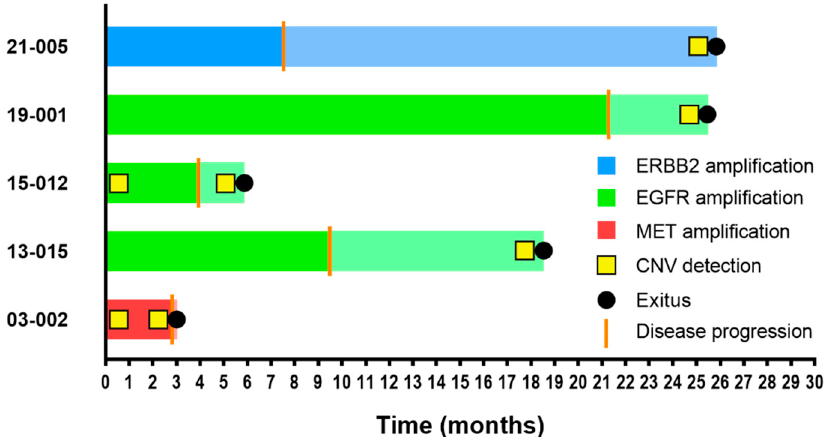
Figure 2. Swimmer plot of PFS and OS in CNV-positive patients. The PFS bar plot appears in dark color, whereas OS is represented continuing the same bar but in attenuated color. Disease progression and exitus events are shown on bar plots as a vertical orange line and a black dot, respectively. CNV detection by NGS is represented with a yellow square.